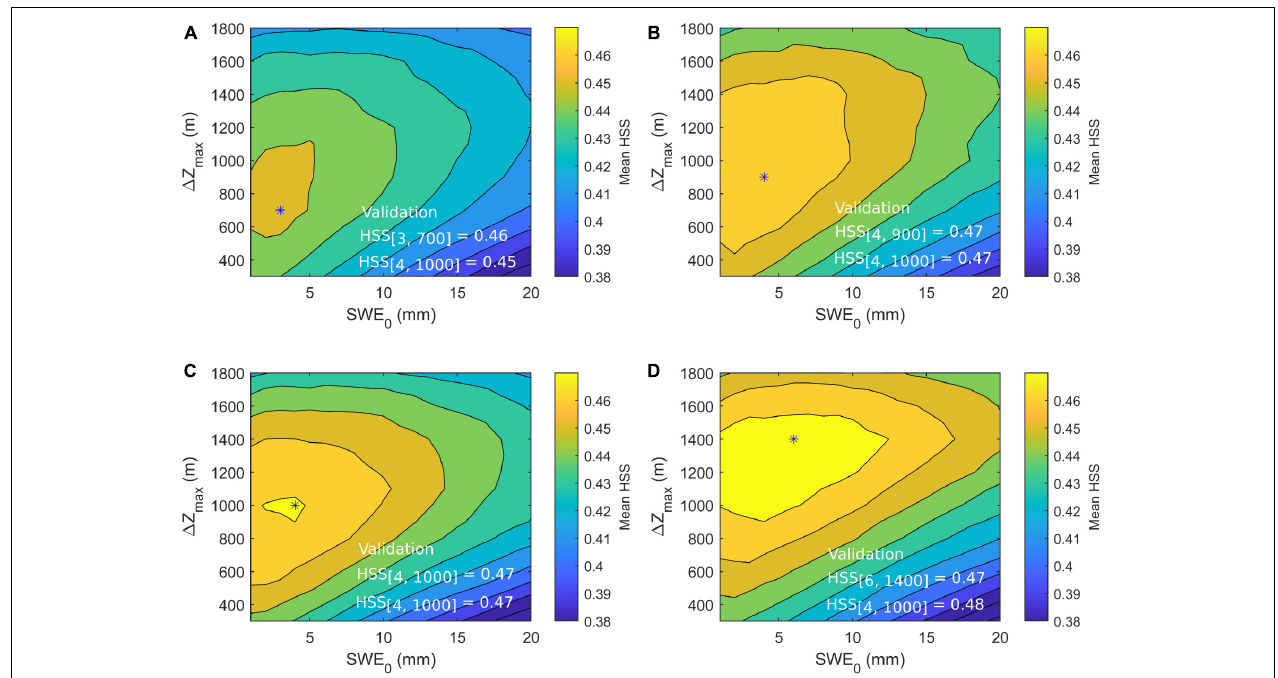
FIGURE 3 | Sensitivity of model SCA simulation performance, as assessed with the mean HSS index, to (cid:52) Z max and SWE 0 parameters over the calibration period. Optimal parameter values are indicated by asterisks (*). The validation HSS statistics for the model-specific and multi-model average optimal parameters are shown in white. (A) TI, (B) HTI, (C) ETIA, and (D)